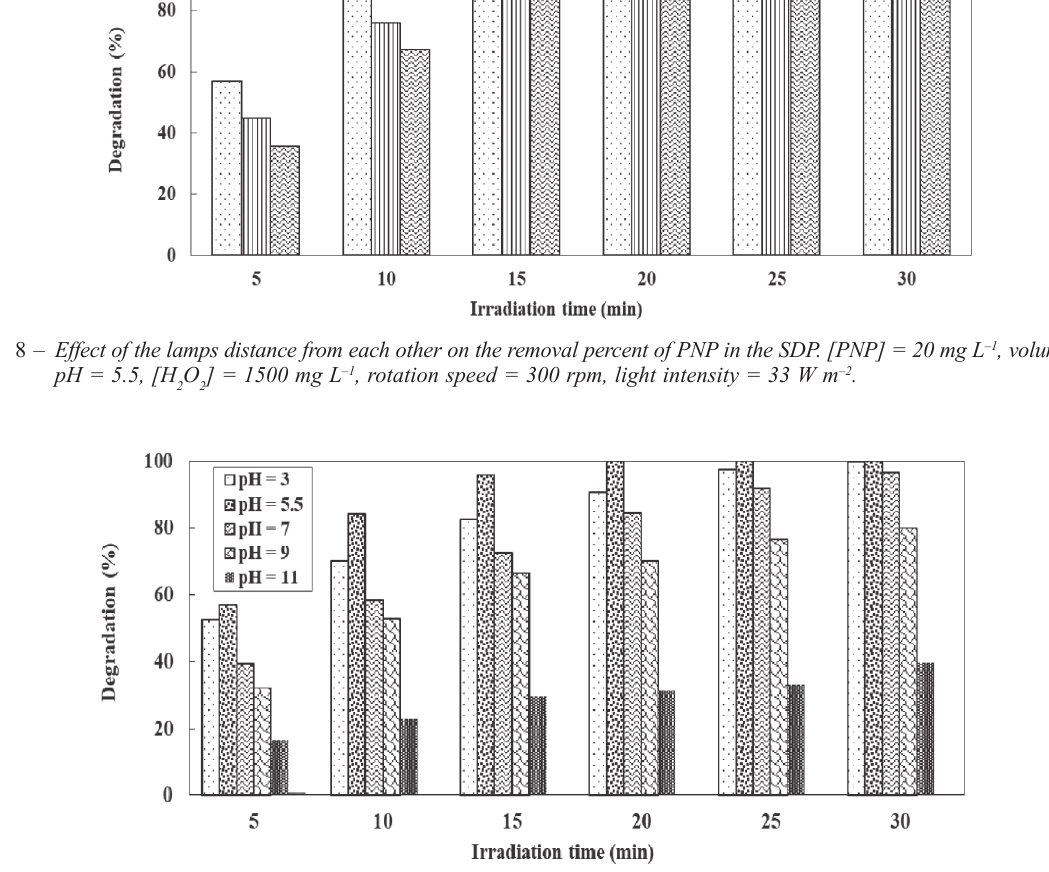
O ] = 1500 mg L –1 , 2 2